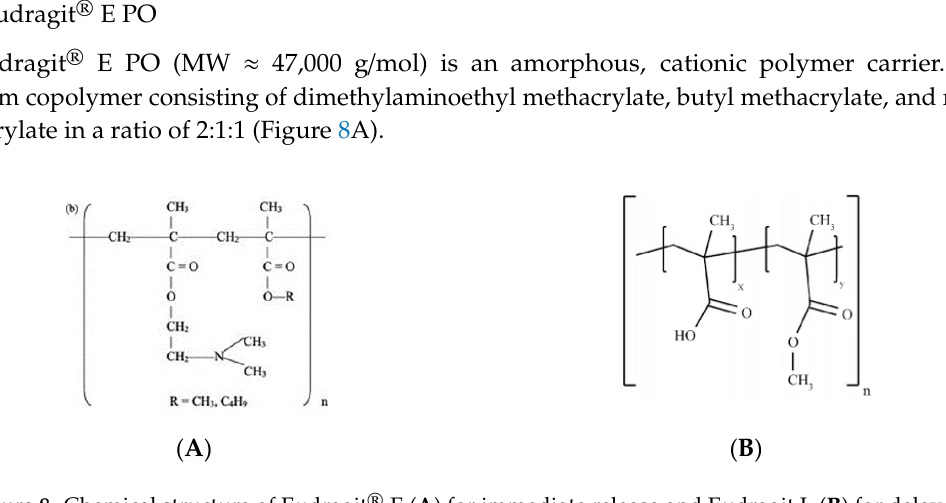
Figure 8. Chemical structure of Eudragit ® E ( A ) for immediate release and Eudragit L ( B ) for delayed release [113,114].